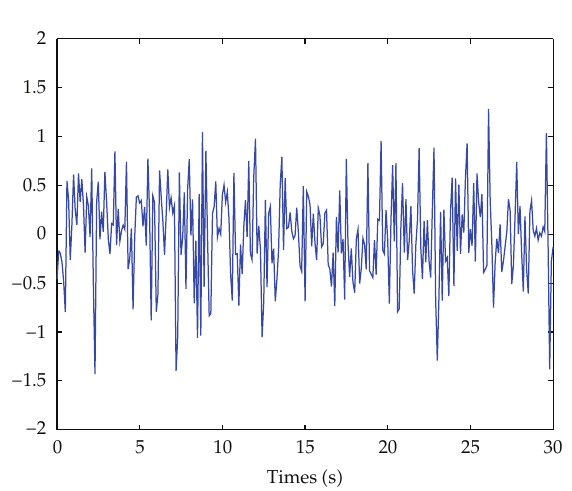
Figure 3: The unknown input ν (cid:6) t (cid:7)